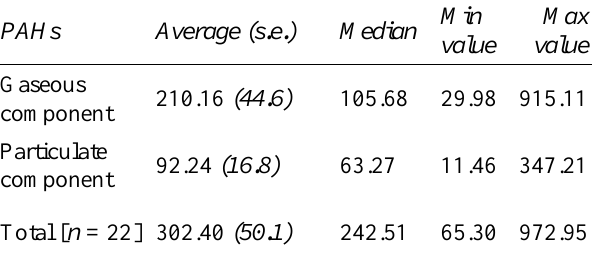
Table 1: Distribution of total PAHs concentration (ng m -3 ) in gaseous and particulate components for the total collecting sites. Values at each collecting site were estimated as the sum of 16 PAHs concentrations analyzed throughout the sampling period [n = 22].